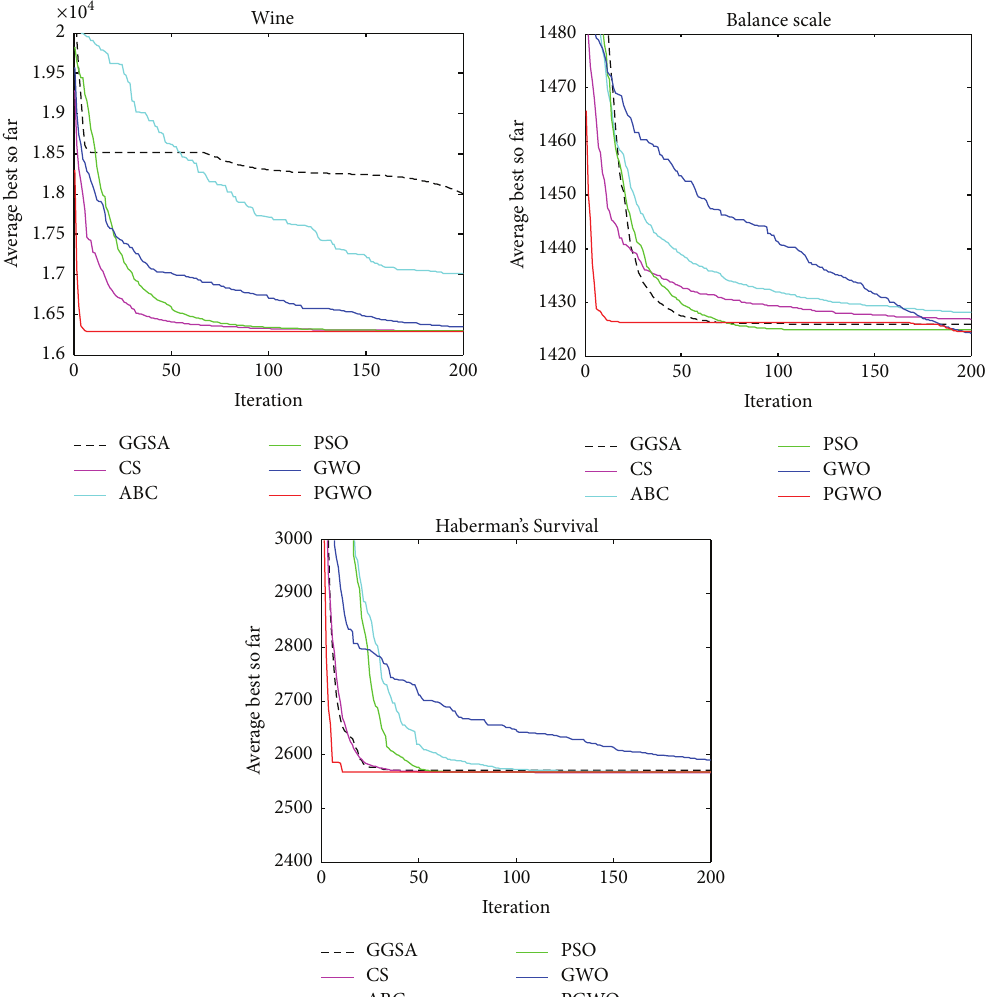
Figure 2: Convergence curves of clustering on data sets over 20 independent